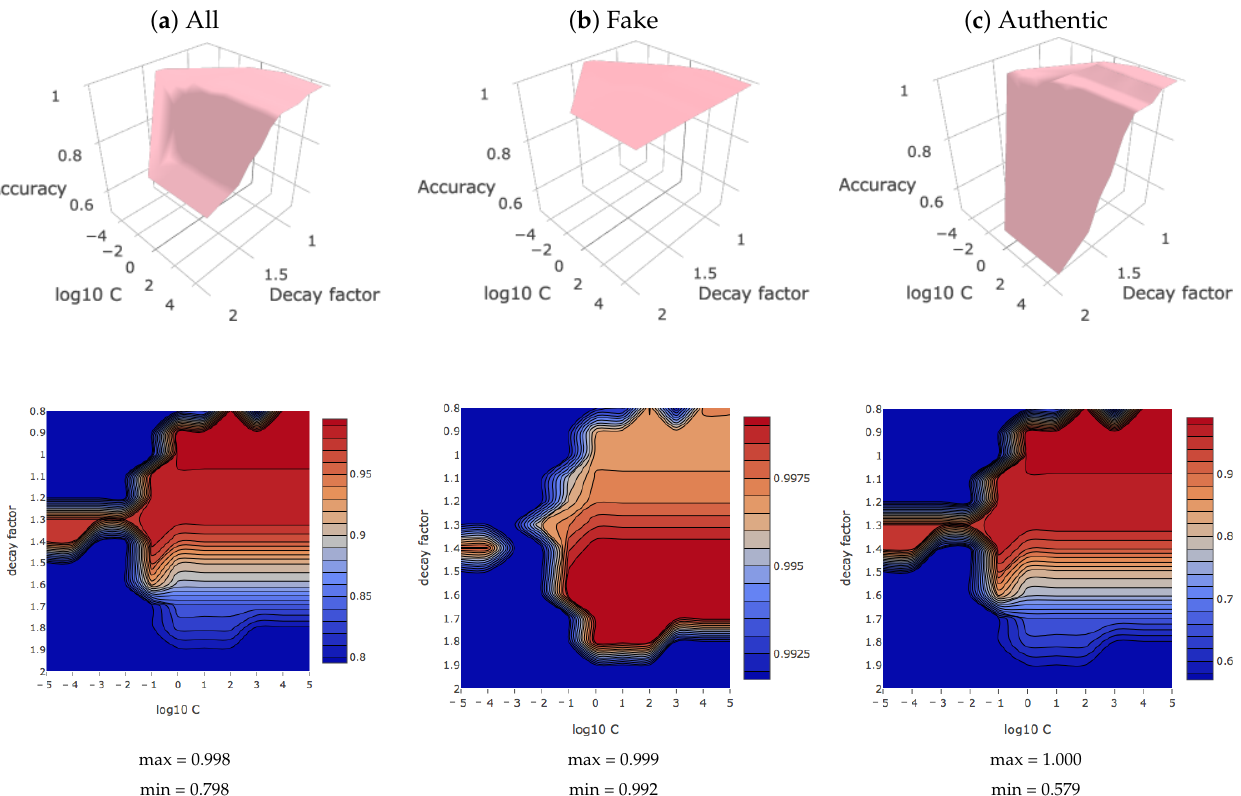
Figure 18. Accuracy scores for 5946 validation examples with a model that has learnt 1000 training